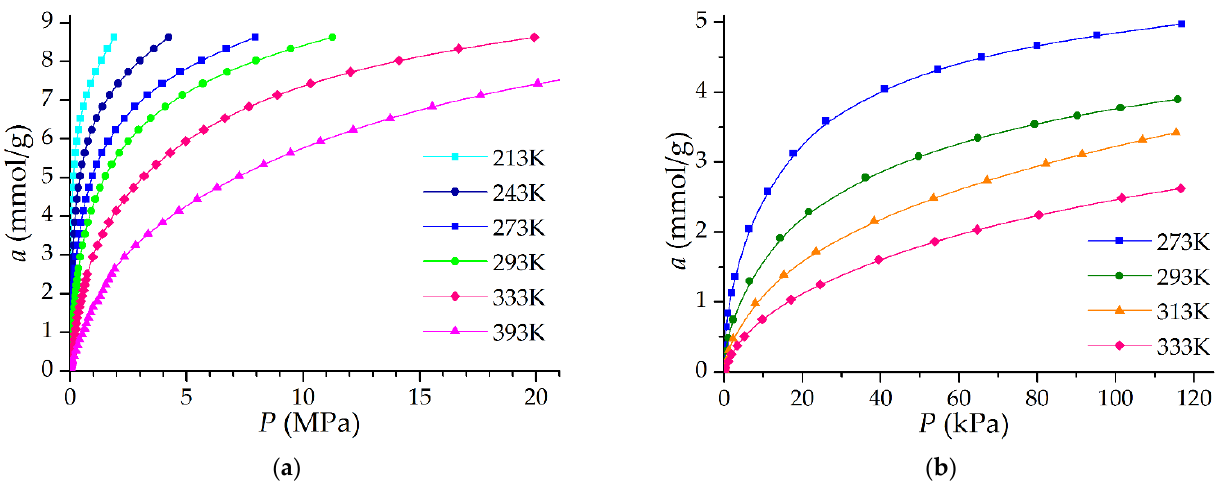
Figure 7. Adsorption isotherms of methane ( a ) and ethane ( b ) on the ACPK adsorbent. Symbols are an experiment. The lines are a spline approximation.